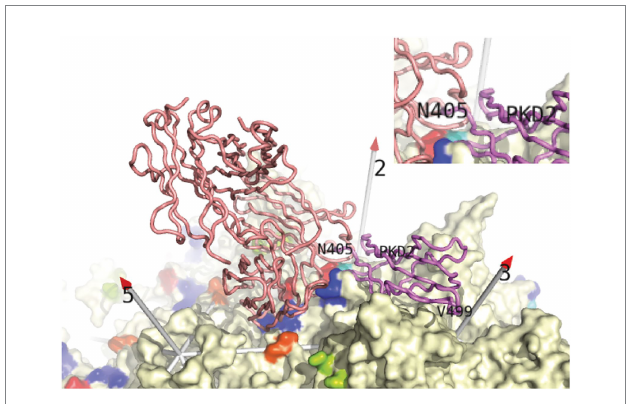
FIGURE 4 Conflict between neutralizing mAb A20 and the AAVR receptor from Stagg et al. (2022). Backbone traces of AAVR PKD2 domain (violet) and the A20 Fab’ structure (salmon) from the structures of AAV2 complexes are overlaid on the surface of the virus (McCraw et al., 2012; Xie et al., 2017; Meyer et al., 2019). Conflict, highlighted in the inset, occurs between the N-terminal residues of PKD2 and the CDR loops of mAb A20 above the spur extending from AAV2’s 3-fold spike. PKD1 was not seen in the single-particle cryo-EM structures (Meyer et al., 2019; Zhang et al., 2019), but was seen at low resolution in recent cryo- electron tomography (Cryo-ET) (Hu et al., 2022). PKD1 is in four orientations extending beyond PKD2 Asn 405 , adding extensively to the overlap with mAb A20. A20 is the only antibody whose complex with AAV is deposited in the structural databases. For structures to which we do not have access (Figure 5), one may still highlight AAV residues reported to be in contact. (Those within 4 Å of A20 are rainbow colored here). Then one could judge how each antibody would be placed to make the identified contacts, and whether there would likely be